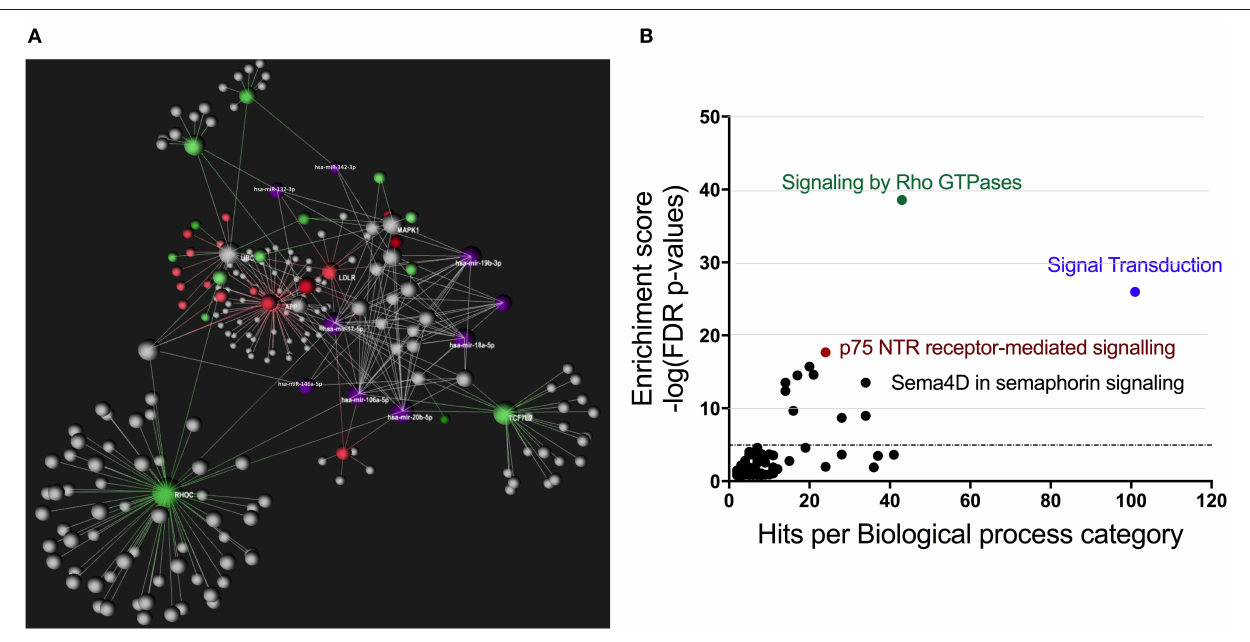
FIGURE 4 | Gene ontology analysis of genes putatively targeted by monocyte subset-specific miRNAs. (A) Using OmicsNet, a force-directed sub-network was constructed for the nine miRNAs with differential expression between classical and non-classical human monocytes (color violet) and their putative target genes extracted from a list of 182 genes with differential expression in classical and non-classical monocyte subsets. Red and green represent genes up- and downregulated, respectively, in classical vs. non-classical monocytes. Genes in gray are those that link genes putatively targeted by miRNAs or are associated in the network. (B) By using Reactome pathway data, we plotted genes with differential expression between monocyte subsets as the number of genes for the respective biological function category (x-axis) against the enrichment score for log10 of p -value (y axis).